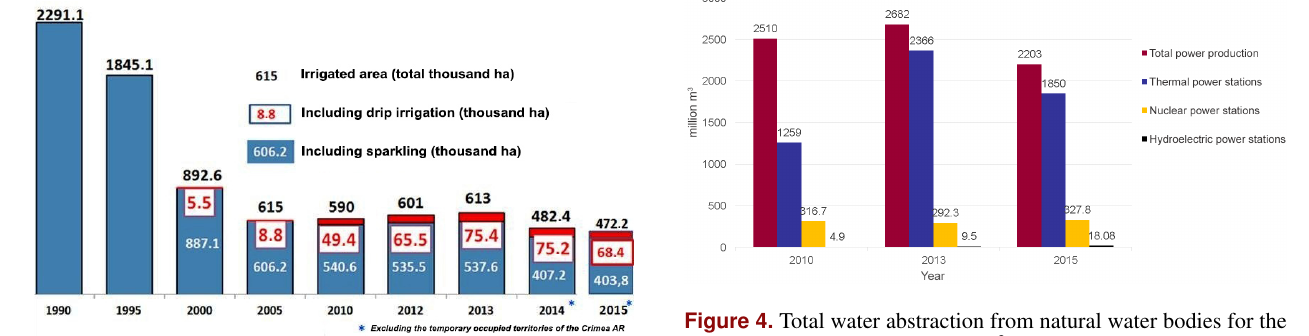
Figure 3. Actual irrigated area.